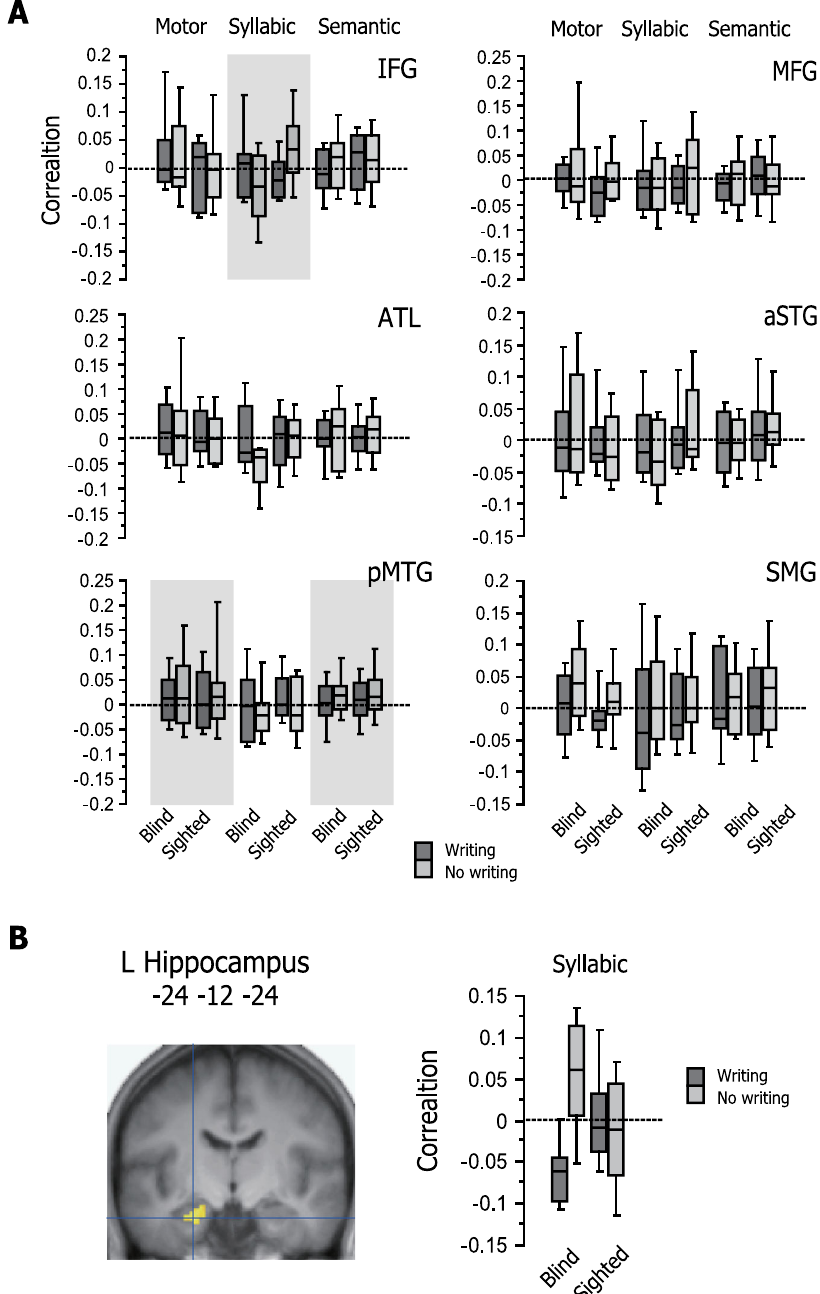
Fig. 5 Correlations with the theoretical RDMs during the test period. A Left hemisphere ROIs. The left pMTG overall showed signi fi cant correlation with the motor and semantic RDMs ( p = 0.050 for both, shaded in gray). On the other hand, the left IFG showed signi fi cant condition× group interaction ( p = 0.030, shaded in gray) for the syllabic RDM. In the left SMG, there was a weak trend of writing with the syllabic RDM ( p = 0.115). No other ROI showed signi fi cant main effects or their interactions with any of the three RDMs ( p > 0.2 for all). For each ROI, box plots of Z -transformed Spearman correlation were calculated at the voxels showing the maximum effect for each RDM. B Searchlight RSA. Signi fi cant condition × group interaction for the syllabic RDM was found in the left IFG ( − 52, 26, 10, Z = 4.11) and the left hippocampus that extended from the anterior to middle segments ( − 24, − 14, − 24, Z = 3.99 and − 28, − 24, − 16, Z = 3.67, that semantic information was more weakly represented for the blind relative to the sighted participants. The two main effects were also non-signi fi cant for the motor RDM ( p > 0.5 for both) but their interaction was marginally signi fi cant ( p = 0.071). The main effects and their interaction were all non-signi fi cant for the syllabic RDM ( p > 0.3 for all).